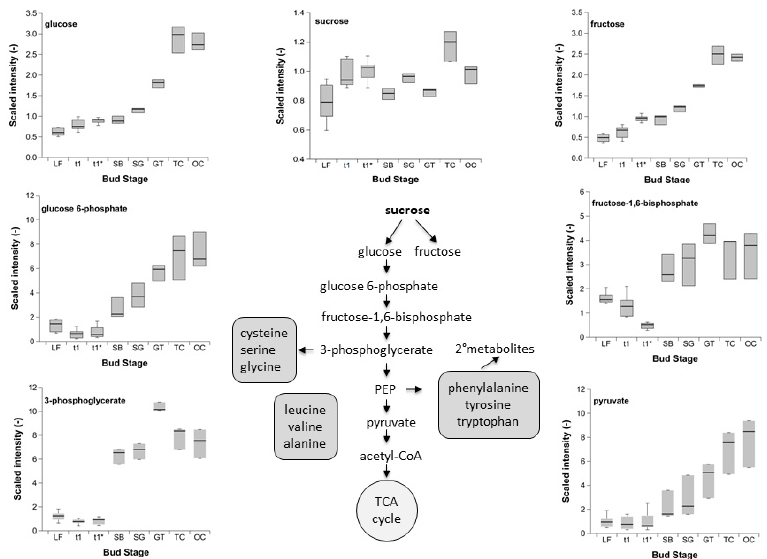
Figure 2. Intensity of sucrose, glucose, fructose and selected intermediates of glycolysis in sweet cherry buds cv. ‘Summit’. ‘Total leaf fall’ (LF), endodormancy release (t 1 ), beginning of ontogenetic development (t 1 *) ‘swollen bud’ (SB), ‘side green’ (SG), ‘green tip’ (GT), ‘tight cluster’ (TC), and ‘open cluster’ (OC). Sample size for the stages LF, t 1 , t 1 * ( n = 6), for the stages between SB and OC ( n = 3).